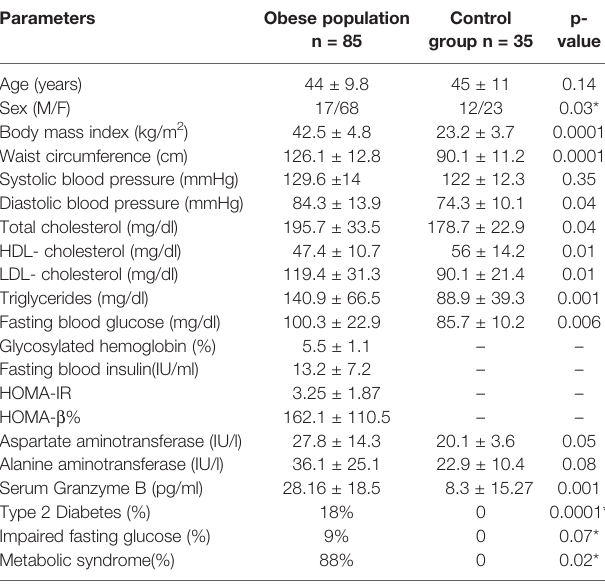
TABLE 1 | Clinical and biochemical characteristics of the obese population in comparison with control group.